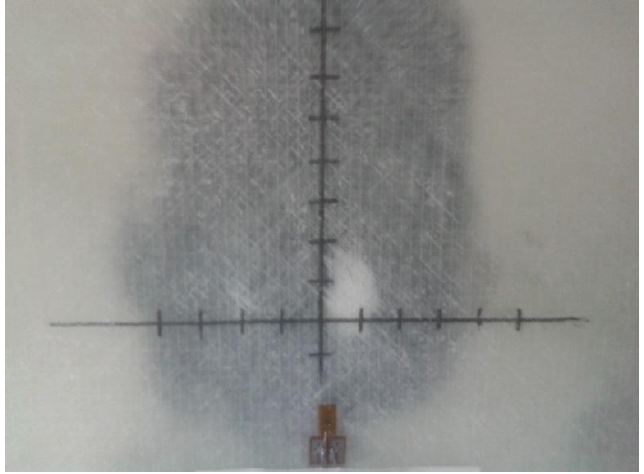
Figure 9. Evolution of unmodified panel D damage at 0.21 × 10 5 impact cycles with P = 810 kN/m 2.